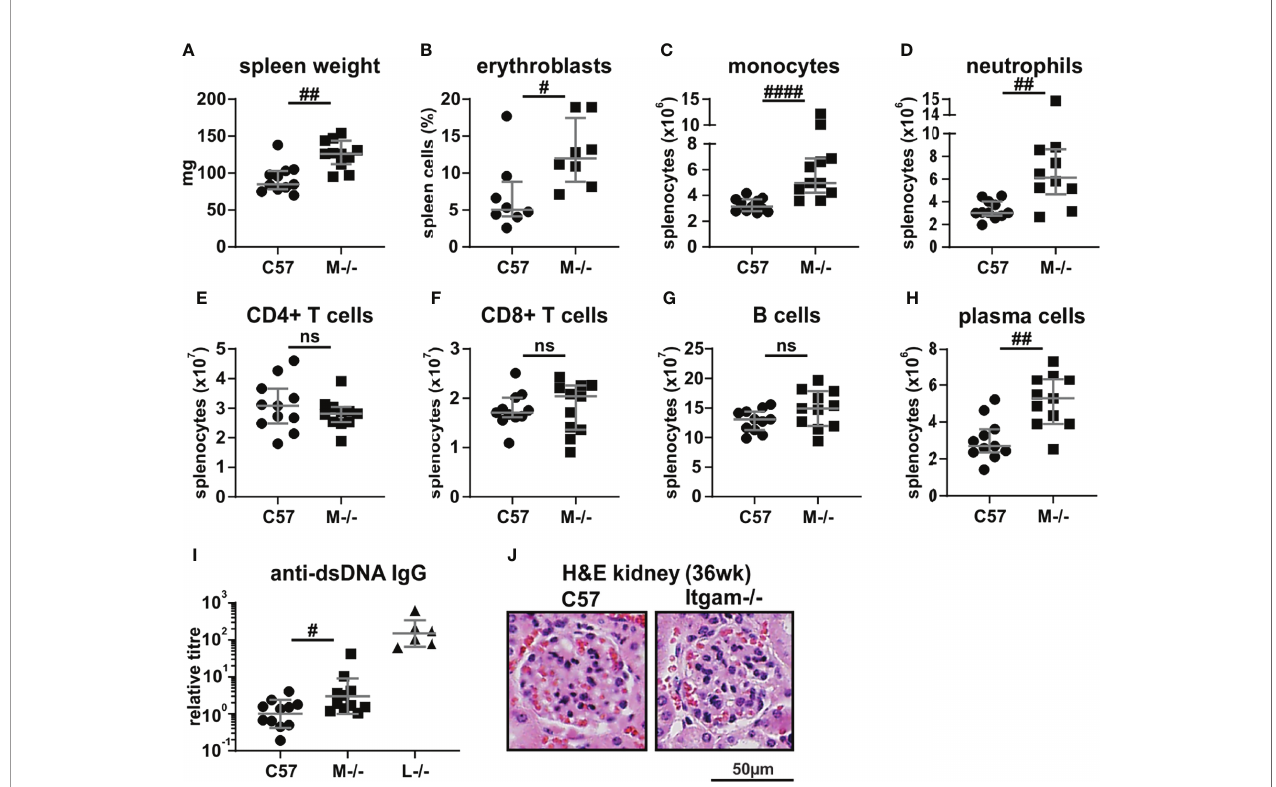
FIGURE 1 | CD11b-de fi ciency elicits immune compartment changes but not autoimmune pathology. 36-week-old C57BL/6 and Itgam -/- mice were assessed for: (A) spleen weights; fl ow cytometric quantitation of splenic populations of (B) erythroblasts, (C) monocytes, (D) neutrophils, (E) CD4+ and (F) CD8+ T cells, (G) B cells and (H) plasma cells; (I) quantitation of systemic titers of anti-dsDNA IgG autoantibodies (with age-matched Lyn -/- (n = 6) positive controls); and (J) glomerular histopathology. For (A – I) , n = 8-11 mice per group, pooled from four experiments. The images in (J) are representative of n = 8-11 mice per group. Not signi fi cant denoted as ns, # p < 0.05, ## p < 0.01, #### p < 0.0001 by Mann-Whitney U